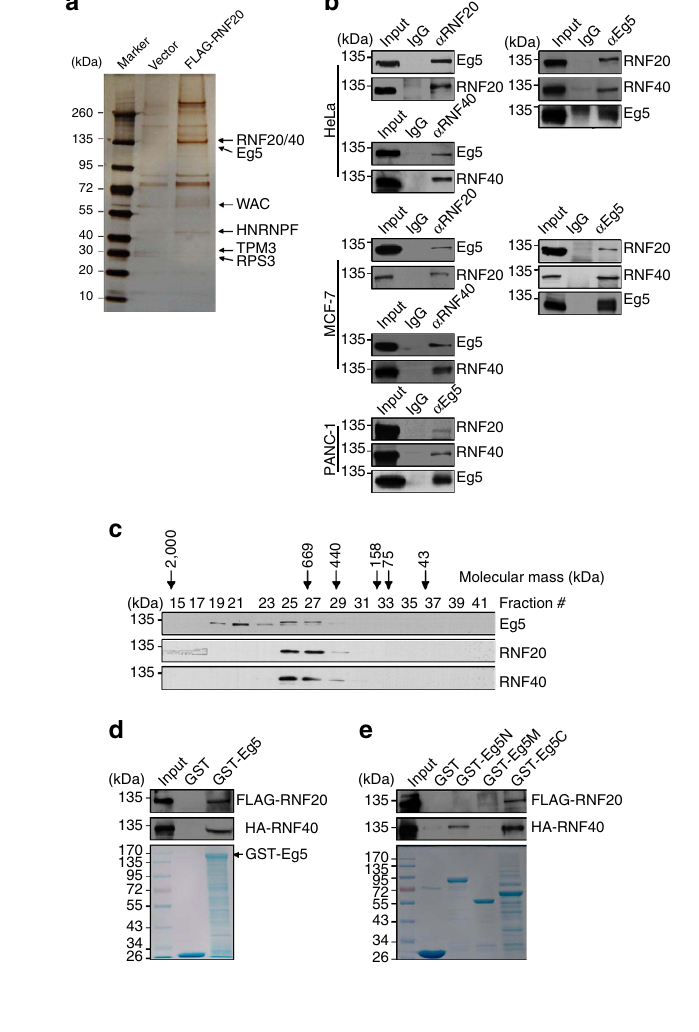
NATURE COMMUNICATIONS|7:13462|DOI: